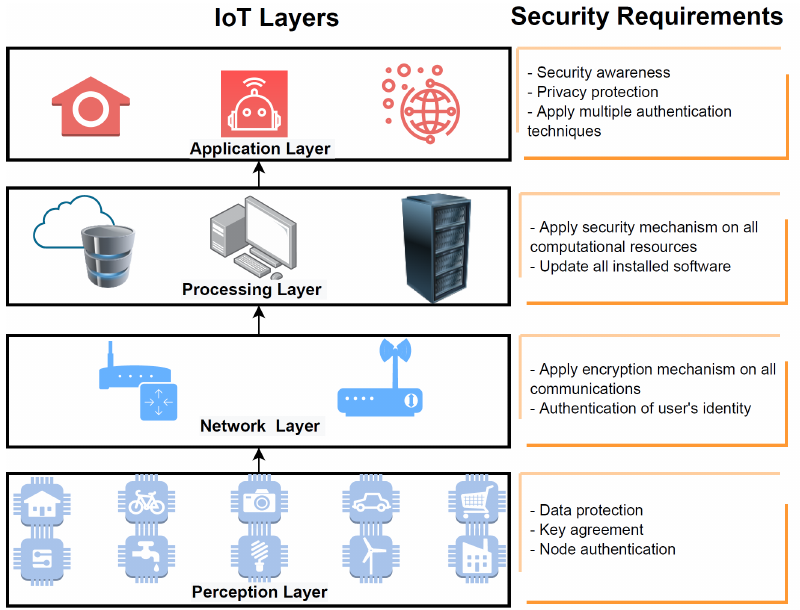
Figure 1. Internet of Things (IoT) Architecture and Security